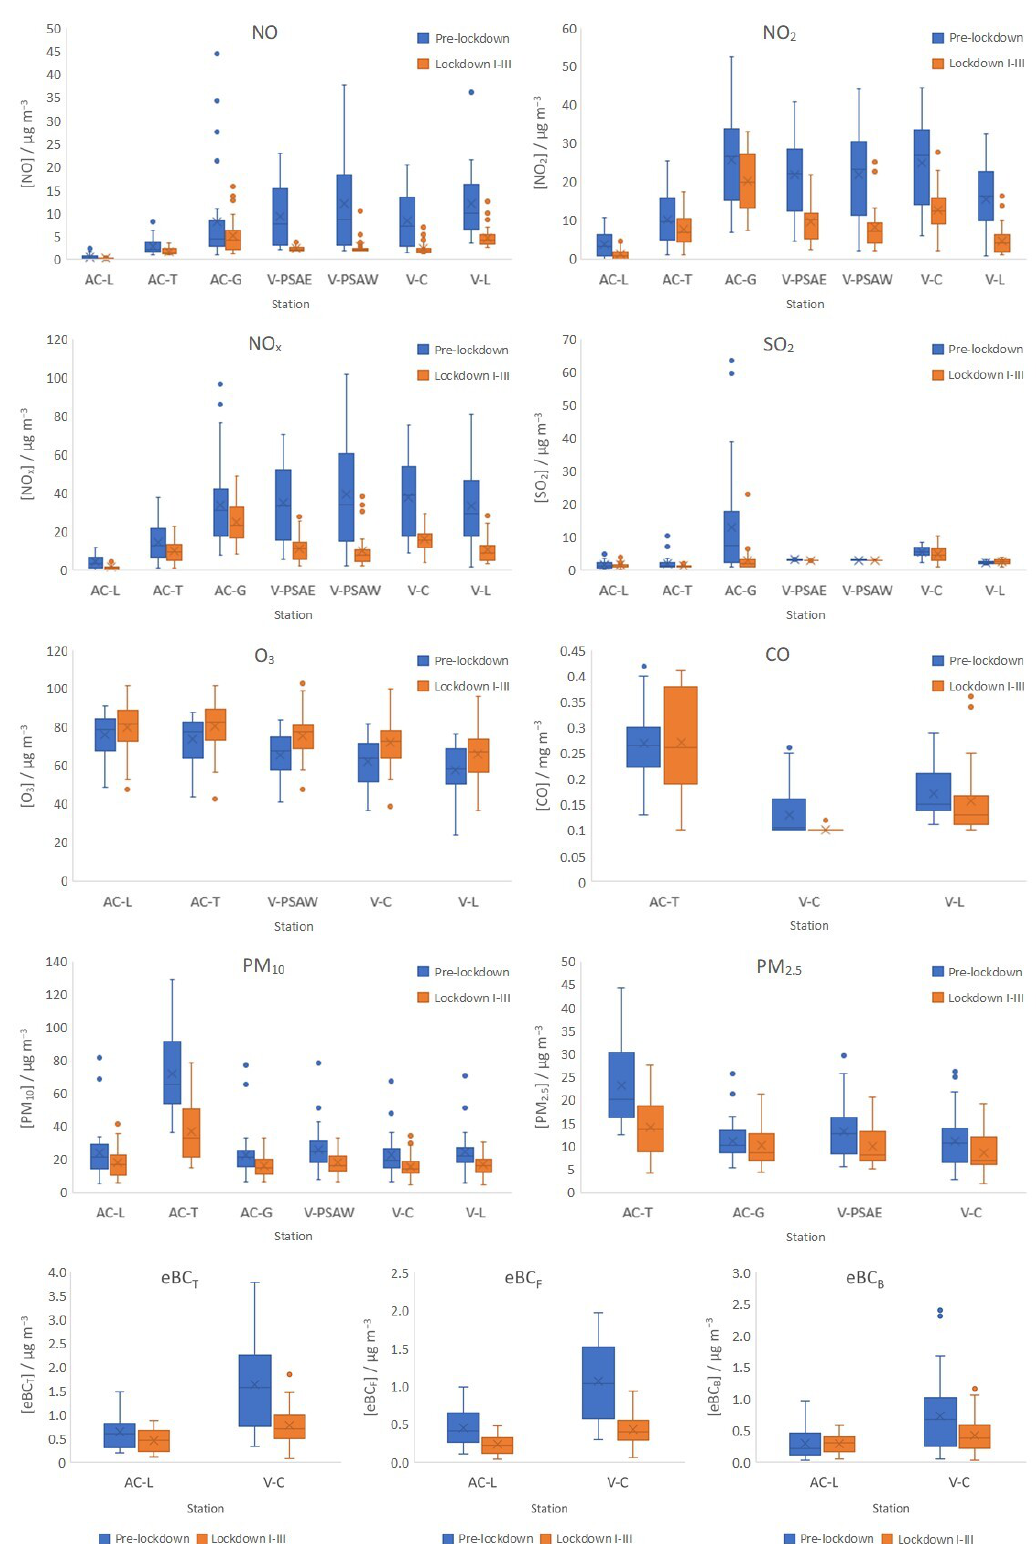
Figure 4. The comparison of NO, NO 2 , NO x , SO 2 , CO, O 3 , PM 10 , PM 2.5 , eBC T , eBC F , and eBC B levels before and during the lockdown period at several air monitoring stations. The upper and lower boundaries of the boxes indicate the 75th and 25th percentiles, respectively; the line within the box marks the median; the X marks the mean; the whiskers above and below the boxes indicate the largest and smallest nonoutlier values, respectively. Outliers (dots) refer to values further than 1.5 times the box length from either end of the box.